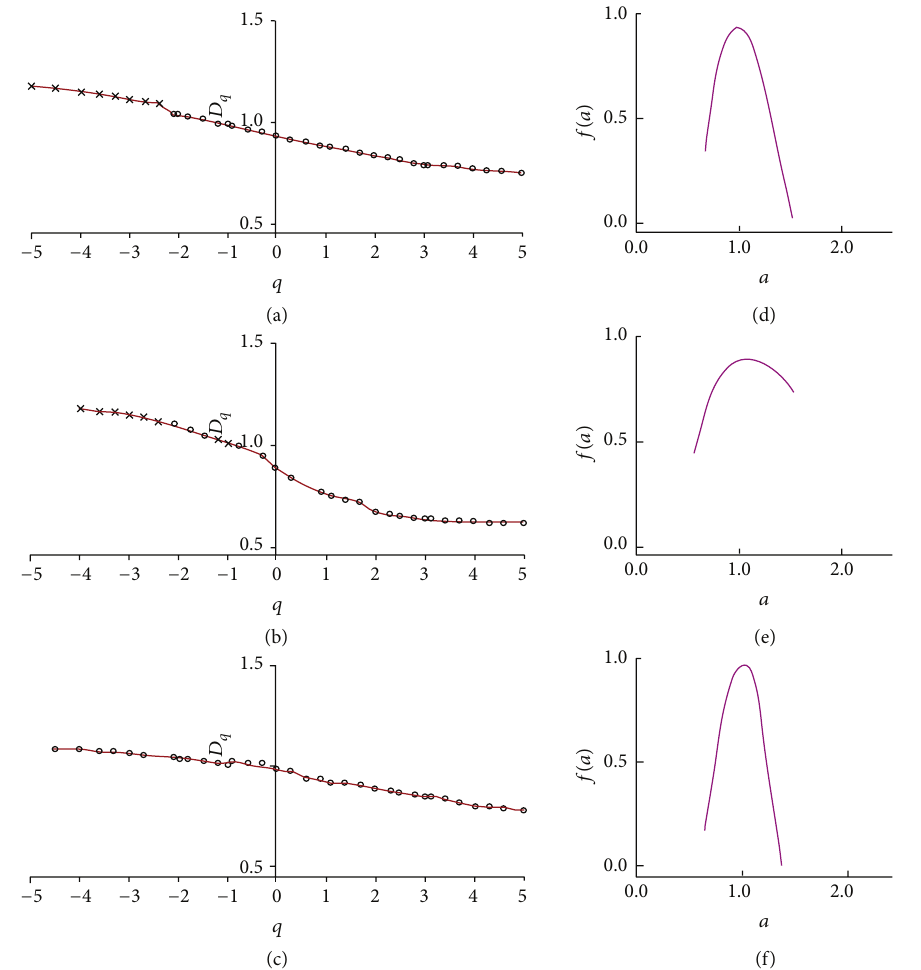
Figure 4: The three variation stages of the generalized dimension spectrum and singularity spectrum before 9 November 1996 Yellow Sea earthquake (M6.1). (a) and (d) show the generalized dimension spectrum and singularity spectrum two years prior to this earthquake, respectively; (b) and (e) show the generalized dimension spectrum and singularity spectrum seventeen months prior to this earthquake, respectively; (c) and (f) show the generalized dimension spectrum and singularity spectrum five months before this earthquake, respectively. The curve of the generalized dimension spectrum in Figure 4(b) is steeper than the two others, and the value range of the singularity spectrum in Figure 4(e) is broader than the two